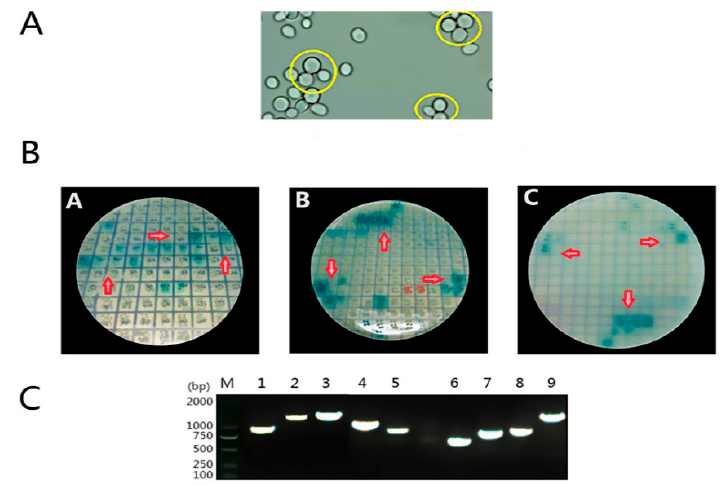
Figure 3. High-stringency screening by the yeast two-hybrid system. ( A ) Observation of zygote three-lobed structures under the microscope. ( B ) Positive blue colonies grow on QDO / X / A nutrient-deficient medium. ( C ) Amplification results of the positive yeast. M, marker 2000; 1–9, amplification of DEF cDNA library gene fragments 700 to 1500 bp in length. Table 2. The information of the gene products interacting with NS3 according to Y2H system screening.